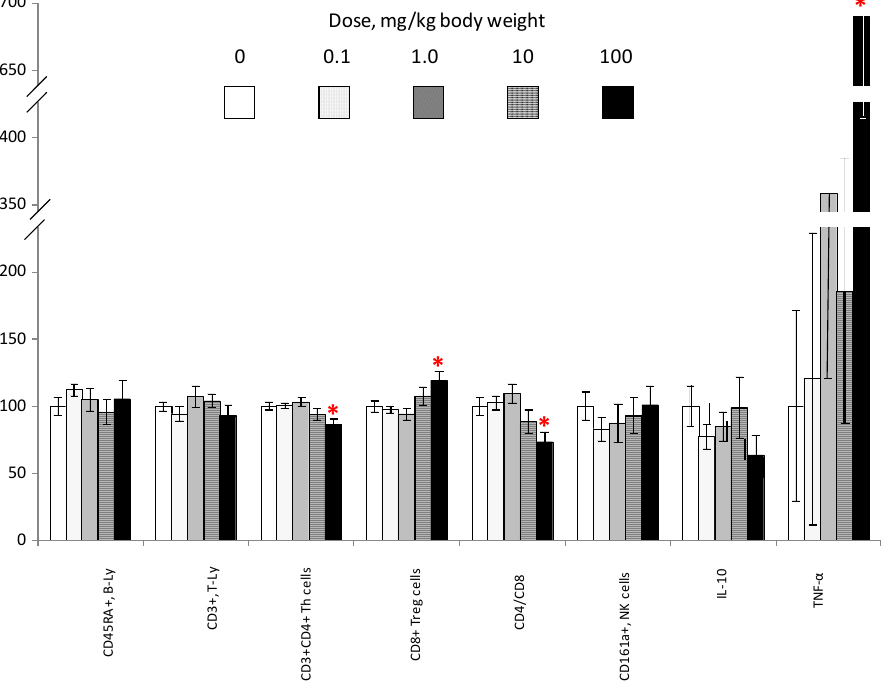
Figure 6. Key indicators of the cellular immunity in rats of 1–5 groups. X-axis—name of indicators, number of samples; y-axis—the values in percent of the control group (group 1), M ± s.e.m. *—Di ff erence with group 1 is significant, Student’s T and Mann–Whitney U